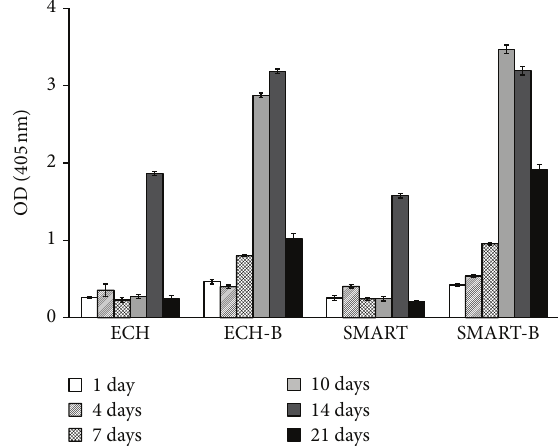
Figure4:ALPactivityofD1cellsseededonvariousTisurfaces.ALP activity of D1 cells on various Ti surfaces coated with or without BMP-2 for 4, 7, 10, 14, and 21d ( 𝑛 = 5 ) (ECH-B: ECH-BMP-2; SMART-B: